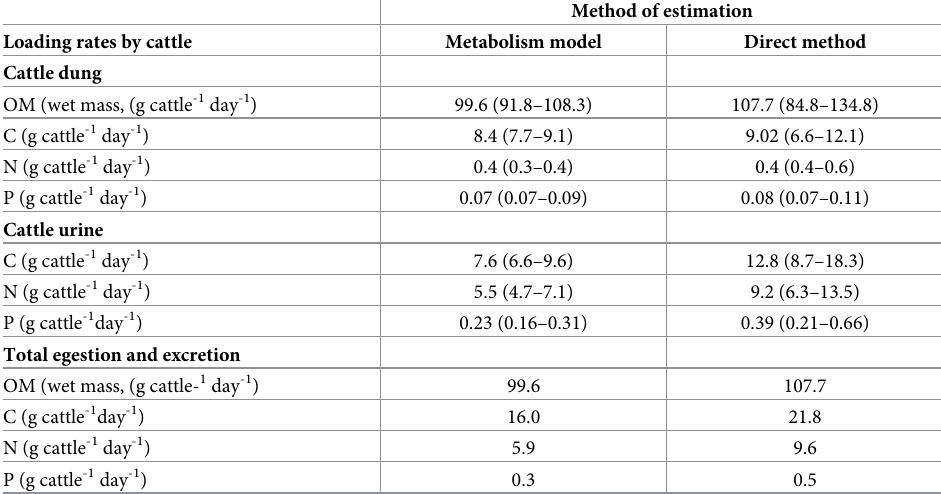
Table 4. Per capita loading rates for organic matter (OM), carbon (C), nitrogen (N) and phosphorus (P) through egestion and excretion by cattle determined by the metabolism model and direct method for the Mara River basin, Kenya. 95% confidence intervals for cattle dung loading rates are provided in